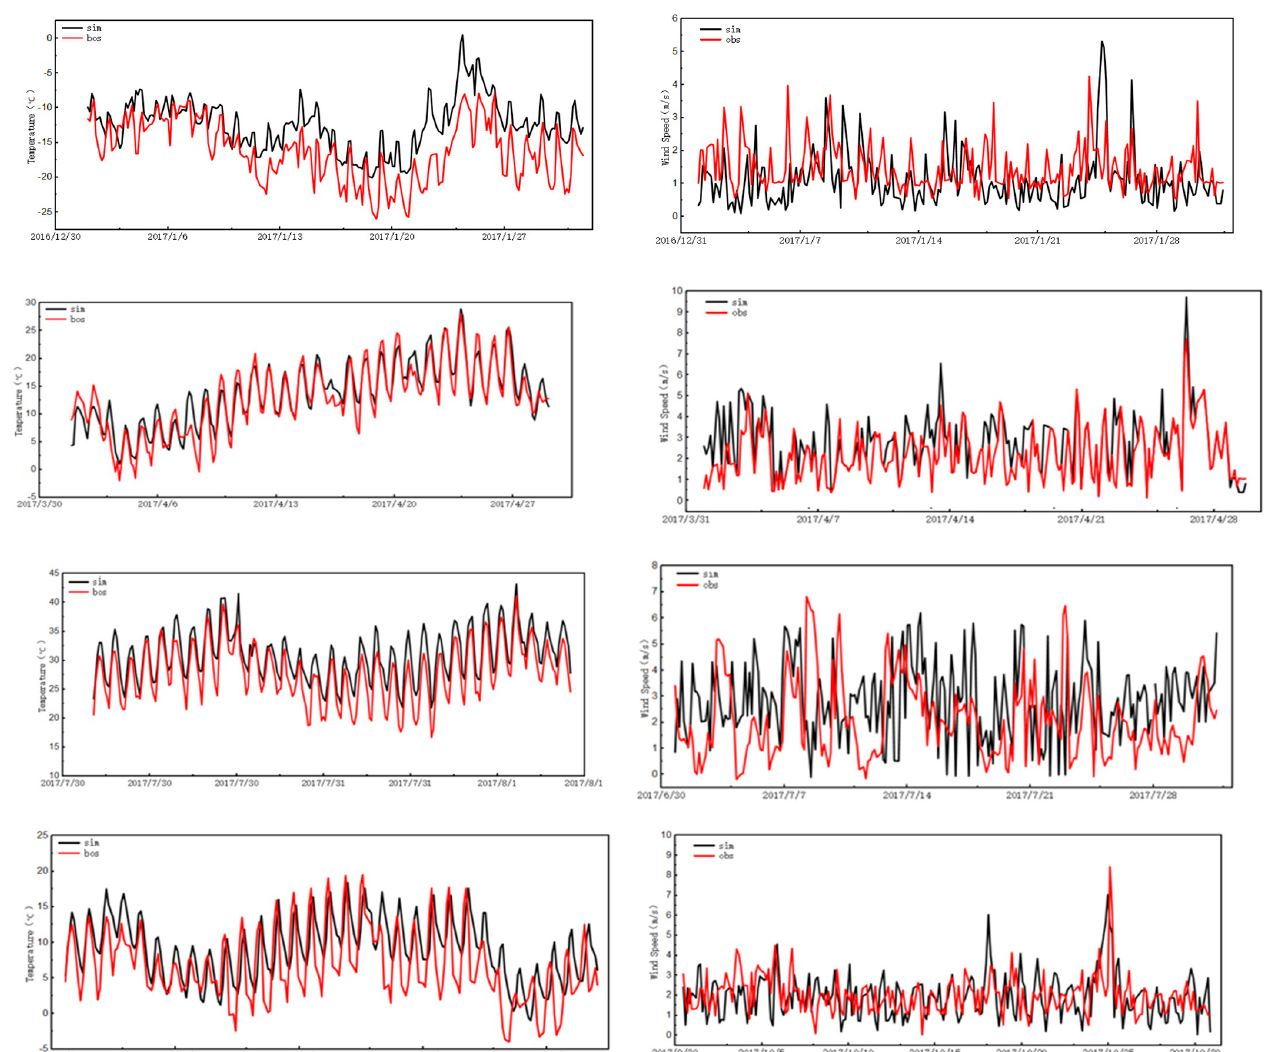
Figure 7. Time series of temperature and wind speed in Bozhou in January, April, July, and Octo- ber 2017. Table 1. Statistical indicators for WRF model evaluation in Bozhou in January, April, July, and